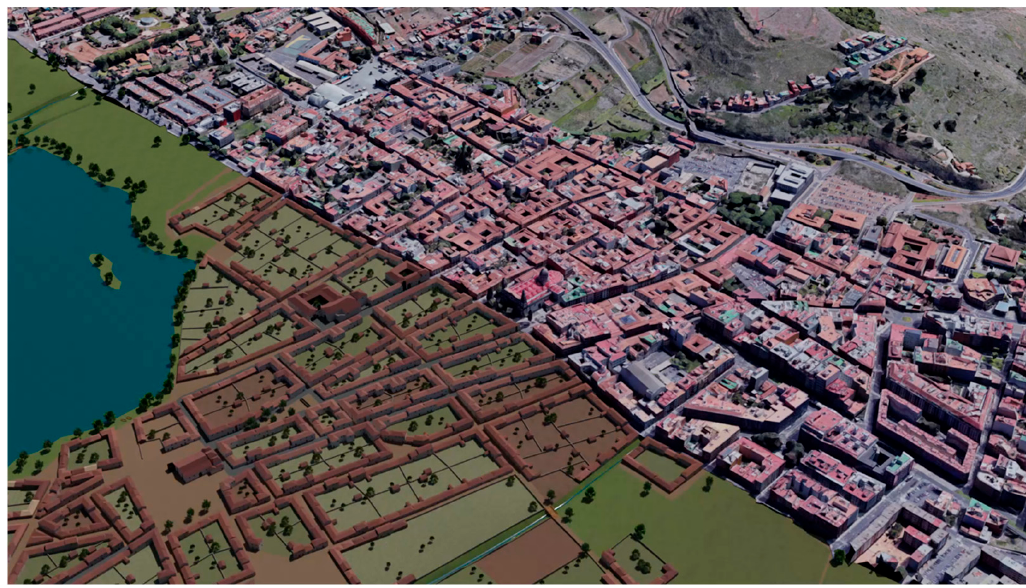
Figure 25. The layout of the city is shared over five centuries by old and new buildings.